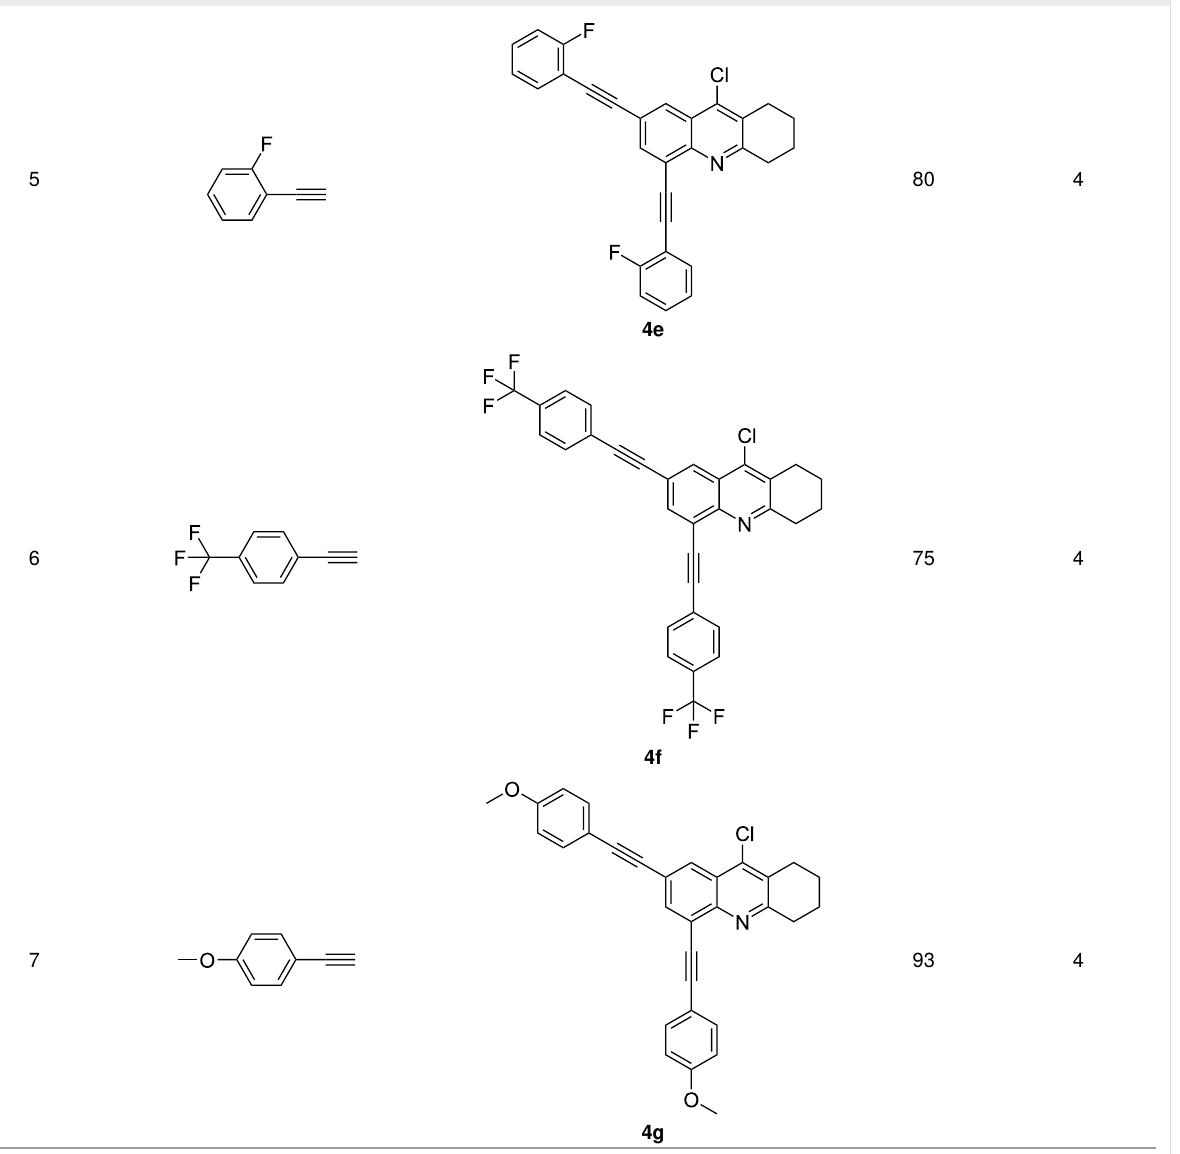
Table 2: Yields of 2,4-bis(arylethynyl)-9-chloro-5,6,7,8-tetrahydroacridine derivatives 4a–g .